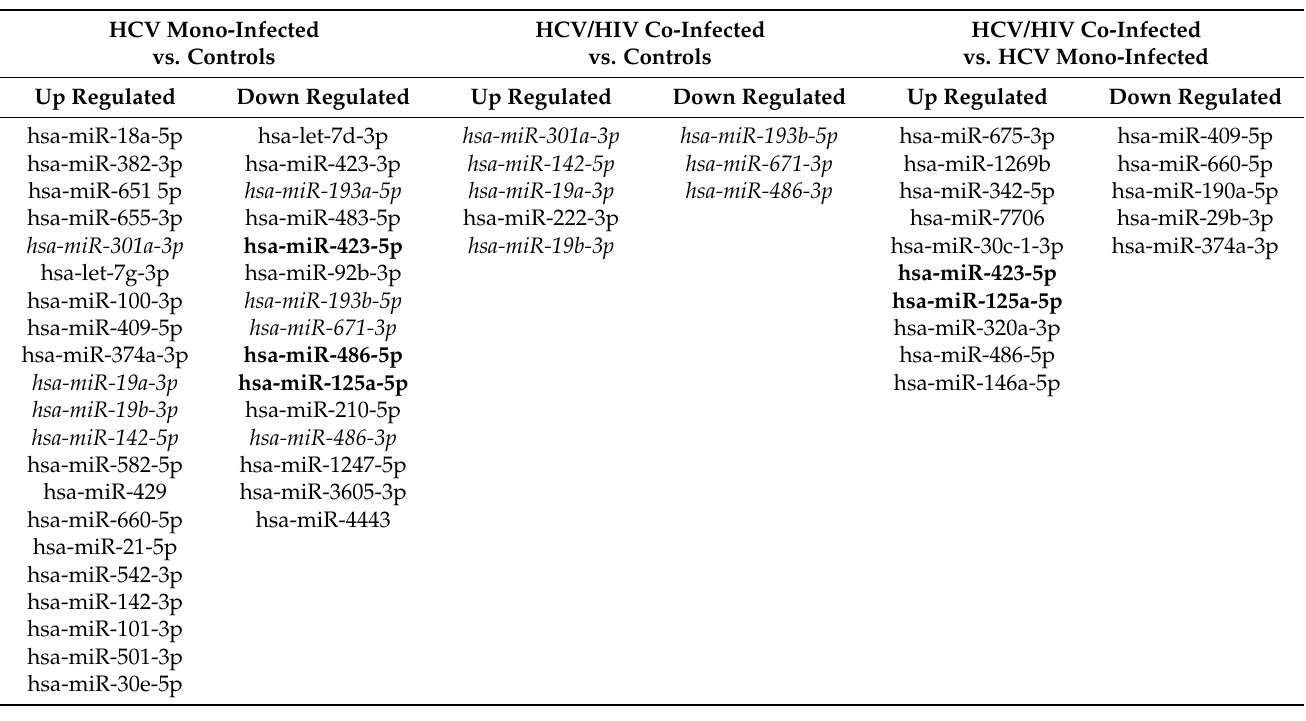
Table 1. List of miRNAs differentially expressed between liver biopsies obtained from: HCV mono- infected patients vs. controls (left columns), HCV/HIVco-infected patients vs. controls (central columns) and HCV/HIV co-infected patients vs. HCV mono-infected patients (right columns). In italics we show miRNAs similarly regulated in HCV- and HCV/HIV-infected patients with respect to controls.